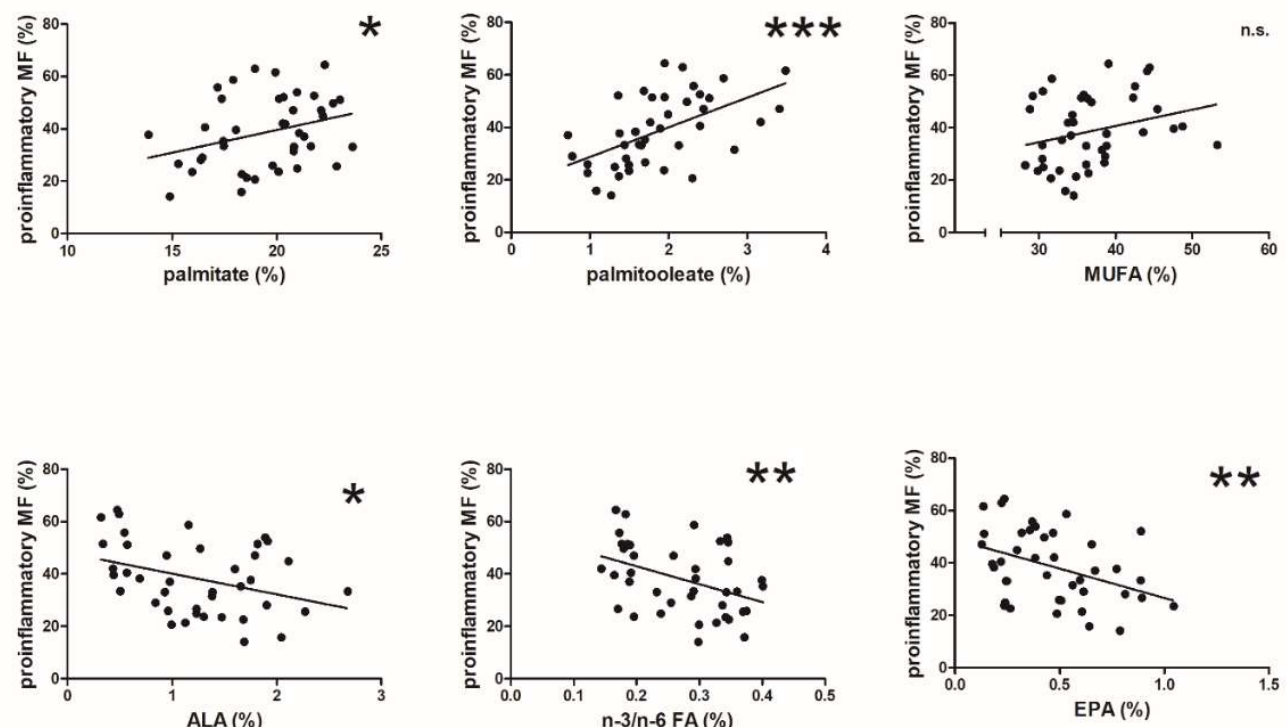
Figure 4. Relation of the proportions of PIMs to those of different FAs of the visceral adipose tissue phospholipids of LKDs ( n = 43, * p < 0.05, ** p < 0.01, *** p < 0.001). Each dot represents data of one subject (LKD). The line express correlation of the data.